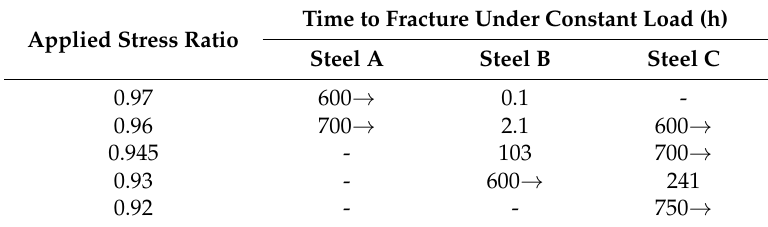
Table 3. Time to fracture under constant tensile load